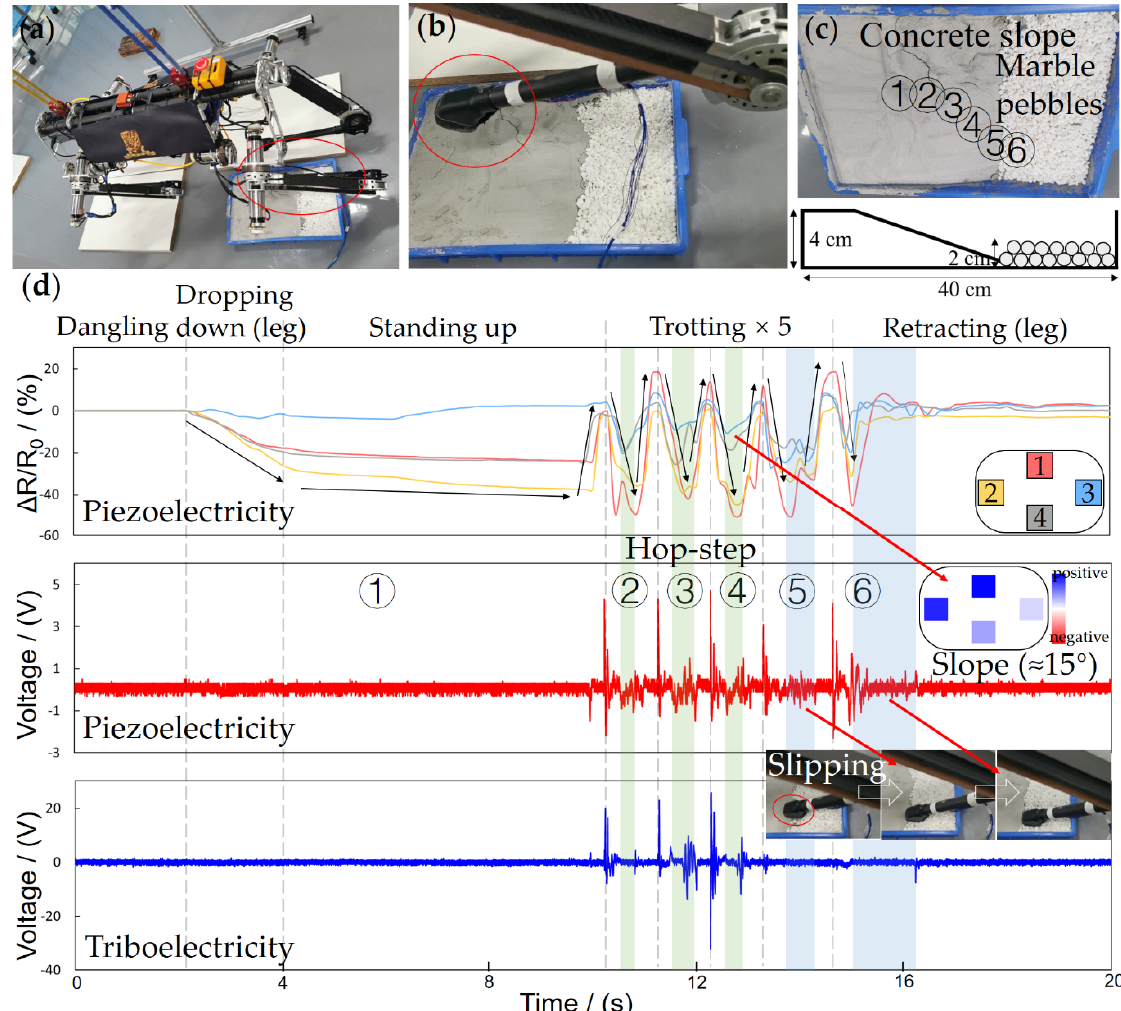
Figure 10. The experiment of FMSS mounted on the foot of ( a,b ) a large size quadruped robot Pegasus without changing the original quadruped foot and leg design. ( c ) The floor pad design with an angle and step points follows the order from 1 to 6. ( d ) FMSS signals in the whole process, which are separated into five states according to the robot’s movements.